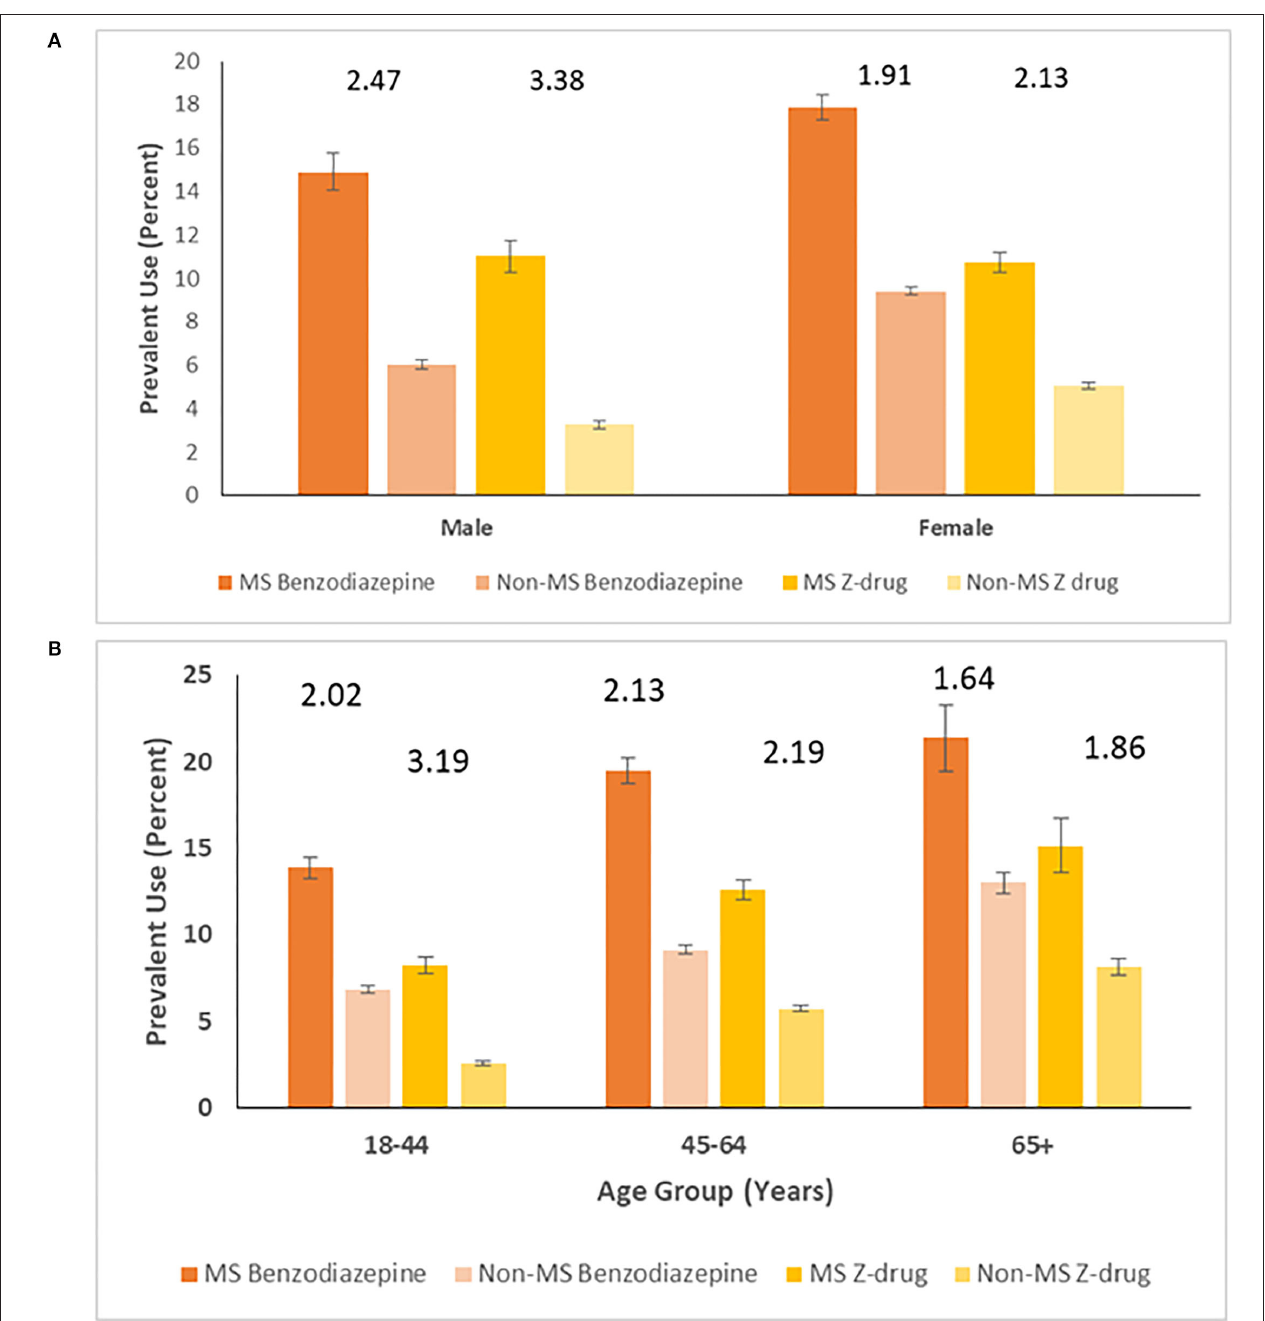
FIGURE 3 | Prevalence (95% CI) of benzodiazepine and Z-drug use per 100 persons in MS and non-MS cohorts, stratified by (A) sex* and (B) age*. *Numbers above columns represent ratios comparing MS and non-MS cohorts.